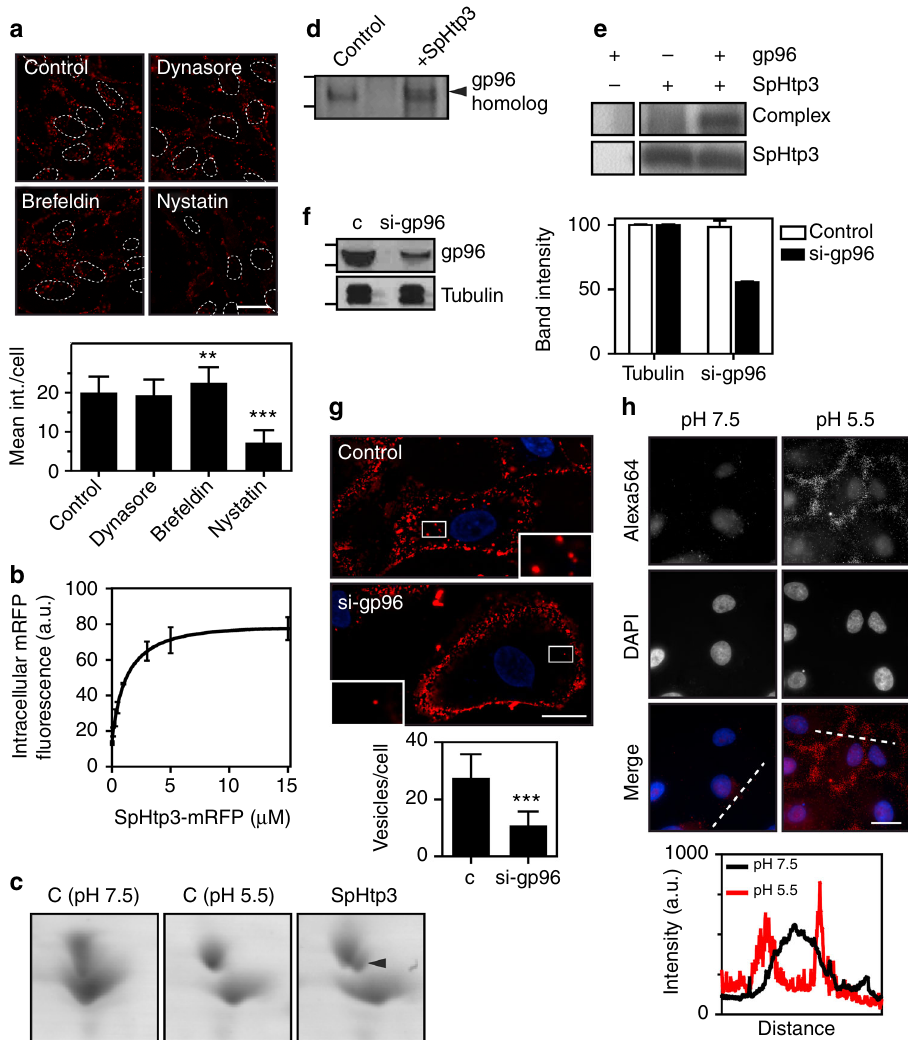
Fig. 4 SpHtp3 is taken up via a gp96-like receptor. a Uptake inhibition of SpHtp3-mRFP into RTG-2 cells pre-incubated for 1 h with the inhibitors dynasore, brefeldin A or nystatin (top) and respective quanti fi cation (bottom). Nuclei are indicated by dashed lines. Error bars denote s.e.m. (cells: 50). *** p < 0.001, ** p < 0.01 (one way ANOVA). Scale bar: 20 µ m ( n = 3). b FACS analysis of the saturable uptake of SpHtp3-mRFP into RTG-2 cells at higher